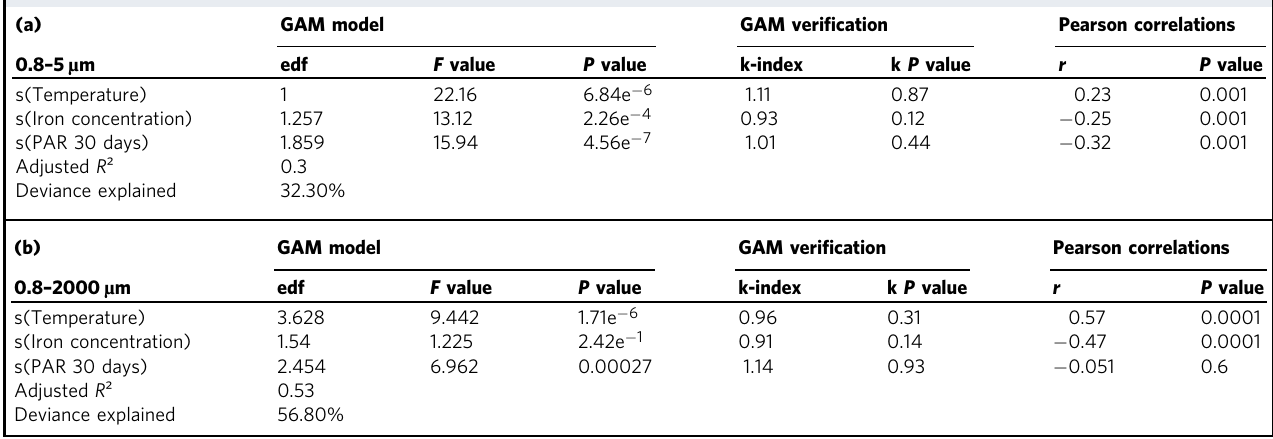
Table 2 Environmental parameters explaining P. calceolata relative abundance for the 0.8 – 5 µ m (a) and the 0.8 – 2000 µ m (b) size